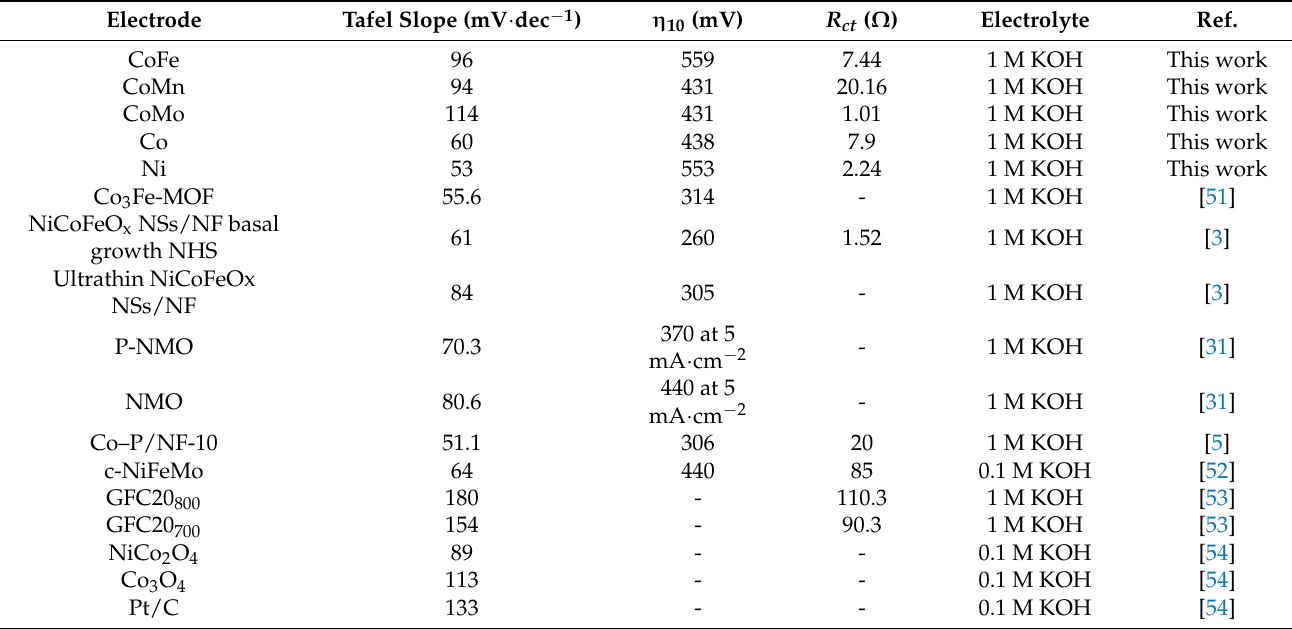
Table 8. Electrochemical performance of herein tested coatings toward OER in alkaline media and comparison with that of transition metal-based electrodes reported in the